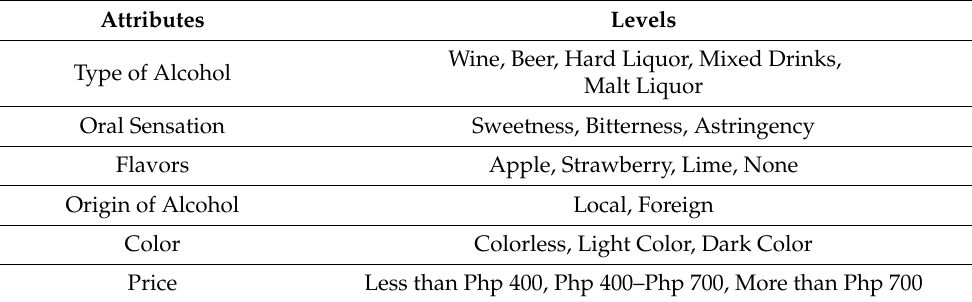
Table 1. Attributes and Levels for Alcohol Beverages.